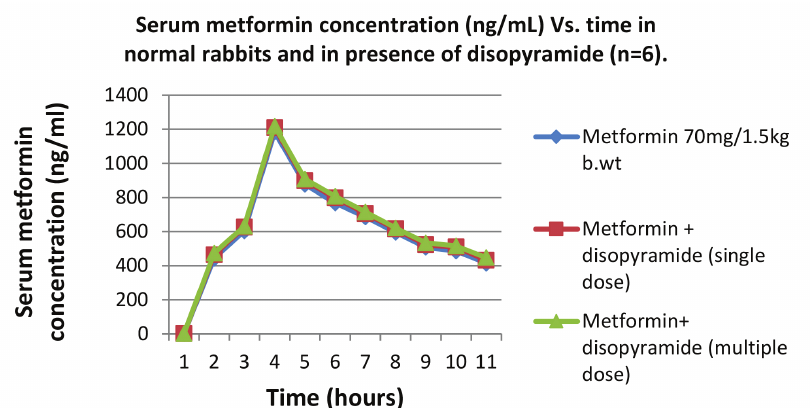
FIGURE 3 - Serum metformin concentration (ng/mL) vs. time in normal rabbits and in presence of disopyramide